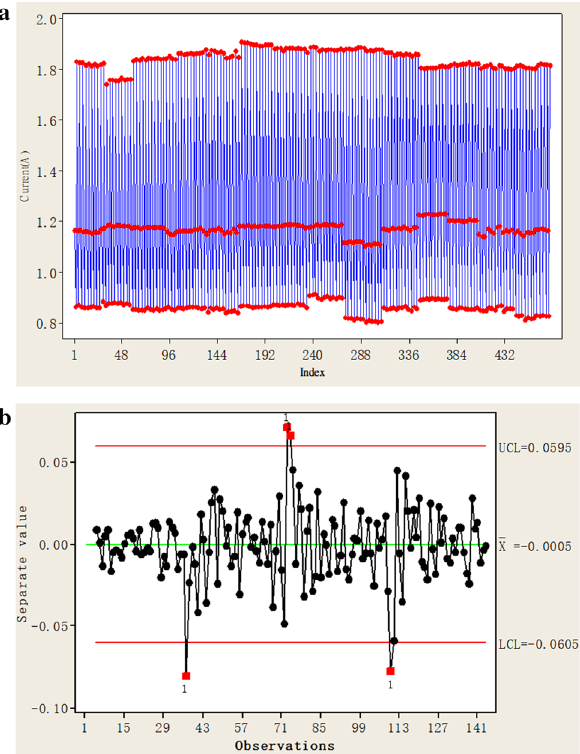
Figure 9. ( a ) The diagram of the employed time series (Calculated by Minitab 16.0 version (Minitab Inc.)). ( b ) The one-way control chart. (Calculated by Minitab 16.0 version (Minitab